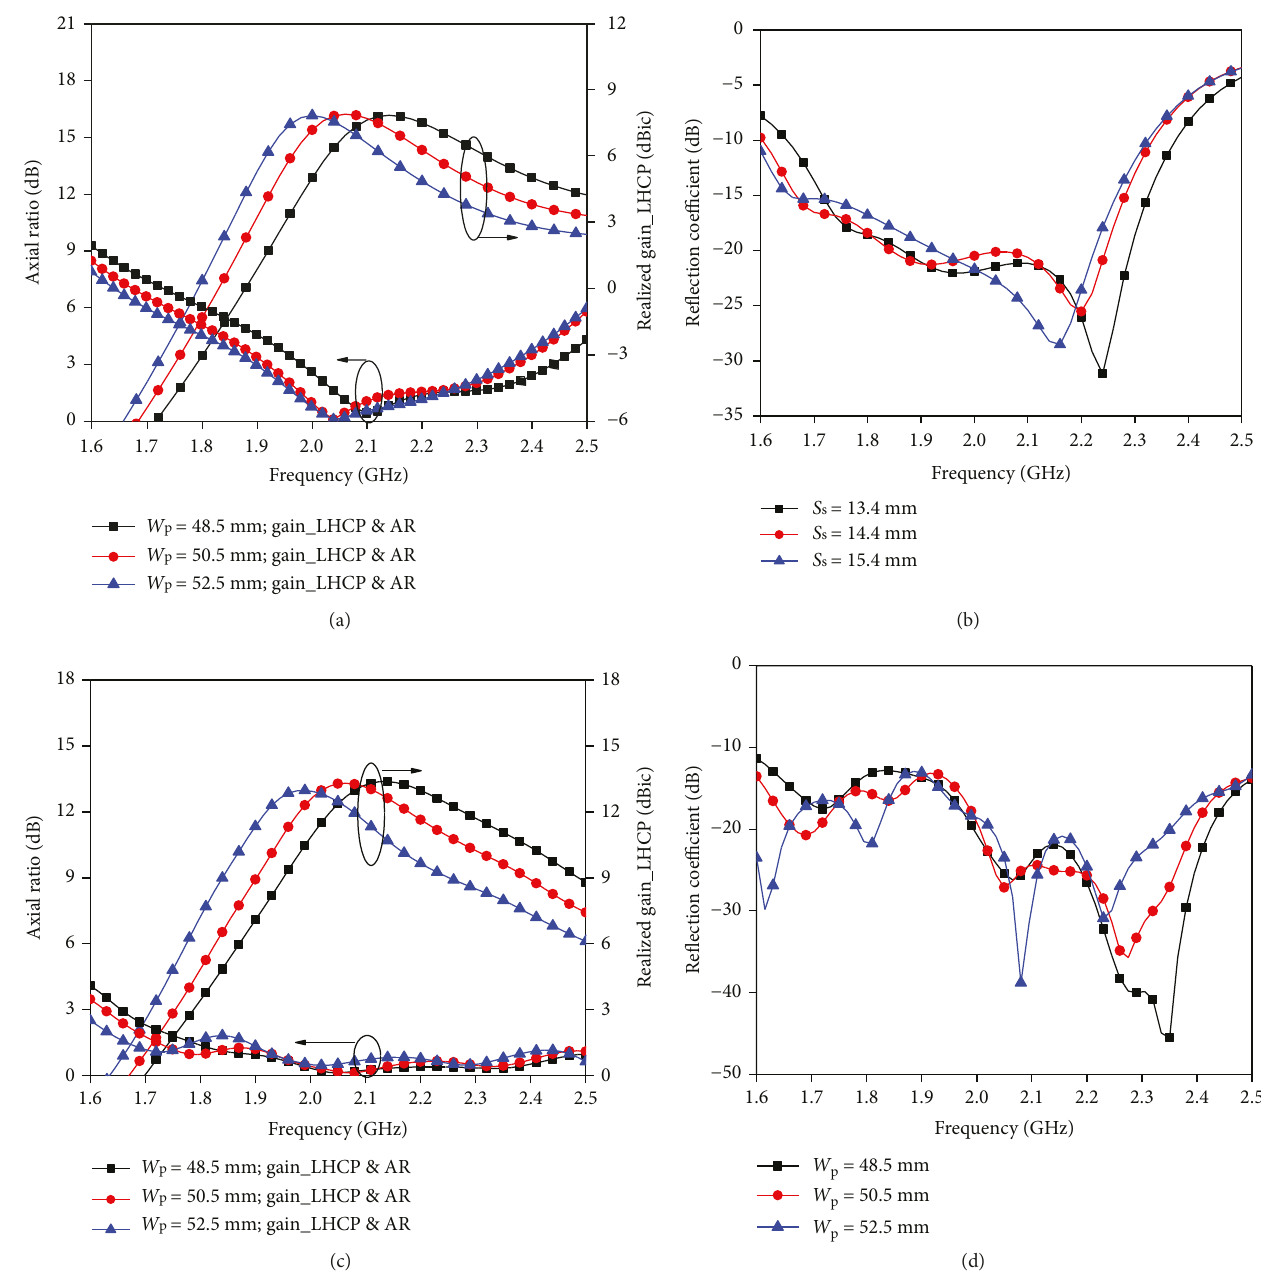
Figure 4: E ff ects of the length of the patch element. (a) Realized gain and axial ratio of the element. (b) Re fl ection coe ffi cient of the element. (c) Realized gain and axial ratio of the array. (d) Re fl ection coe ffi cient of the of W p .